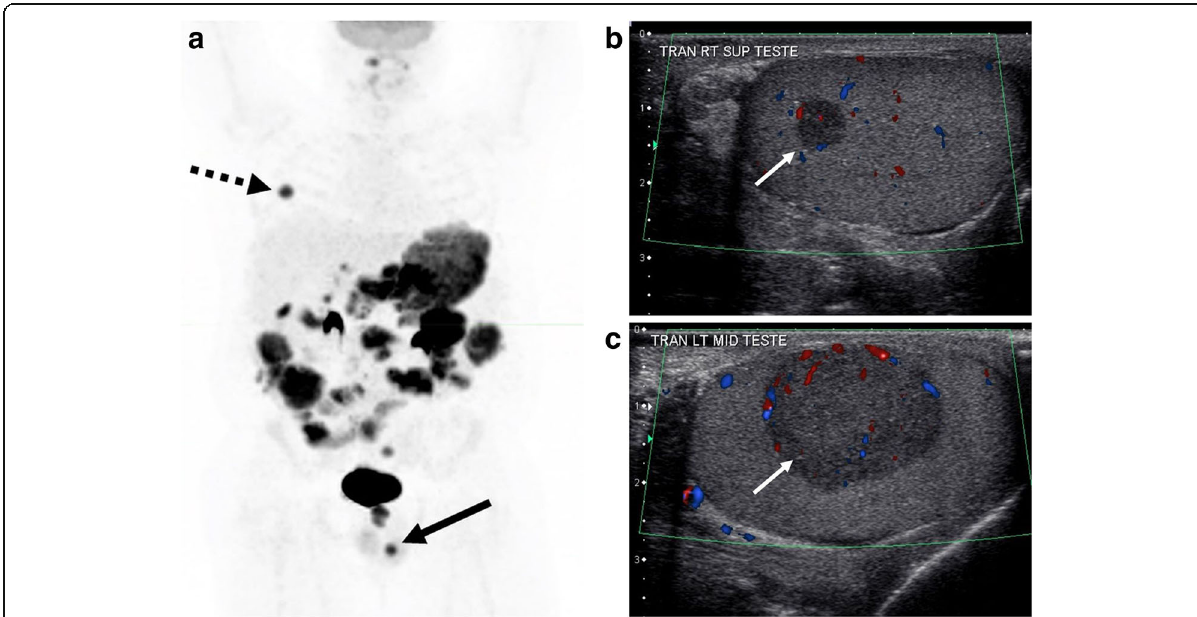
Fig. 8 Bilateral testicular masses. A 39-year-old HIV-positive male with known Burkitt lymphoma. a Whole body planar PET image demonstrates widespread abdominal disease with a small focus of hypermetabolic activity within the region of the left testicle (solid arrow). Less intense, linear activity within the abdomen corresponds to physiologic bowel activity. Small focus of uptake in the right hemithorax (dashed arrow) corresponds to pleural disease. Sagittal color Doppler images through the ( b ) right and ( c ) left testicles demonstrate bilateral hypoechoic testicular masses, left larger than right